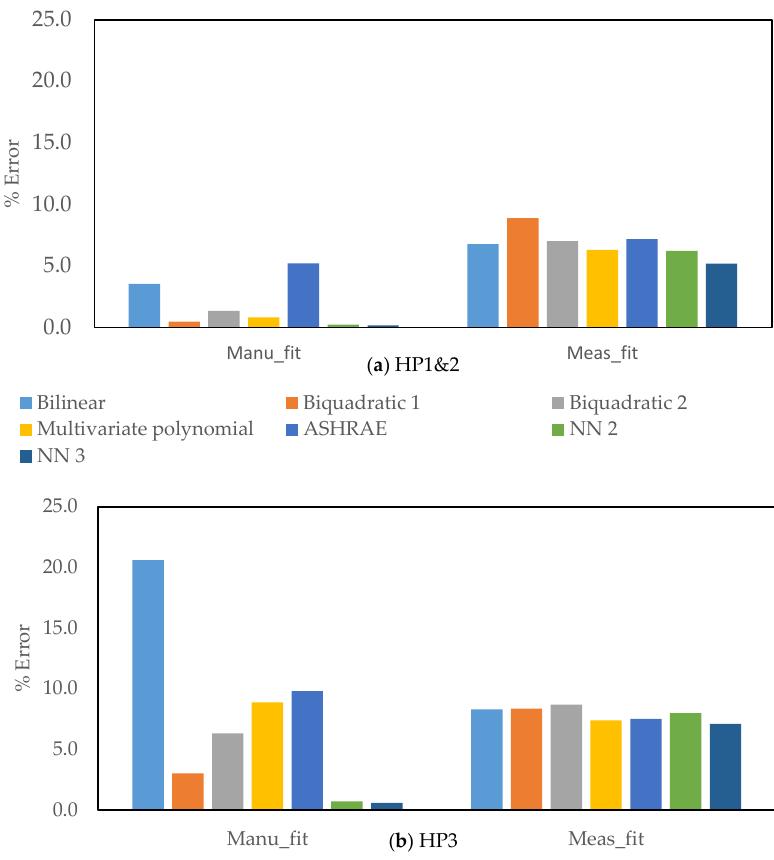
Figure 4. Training error of ( a ) HP1&2; and ( b ) HP3.